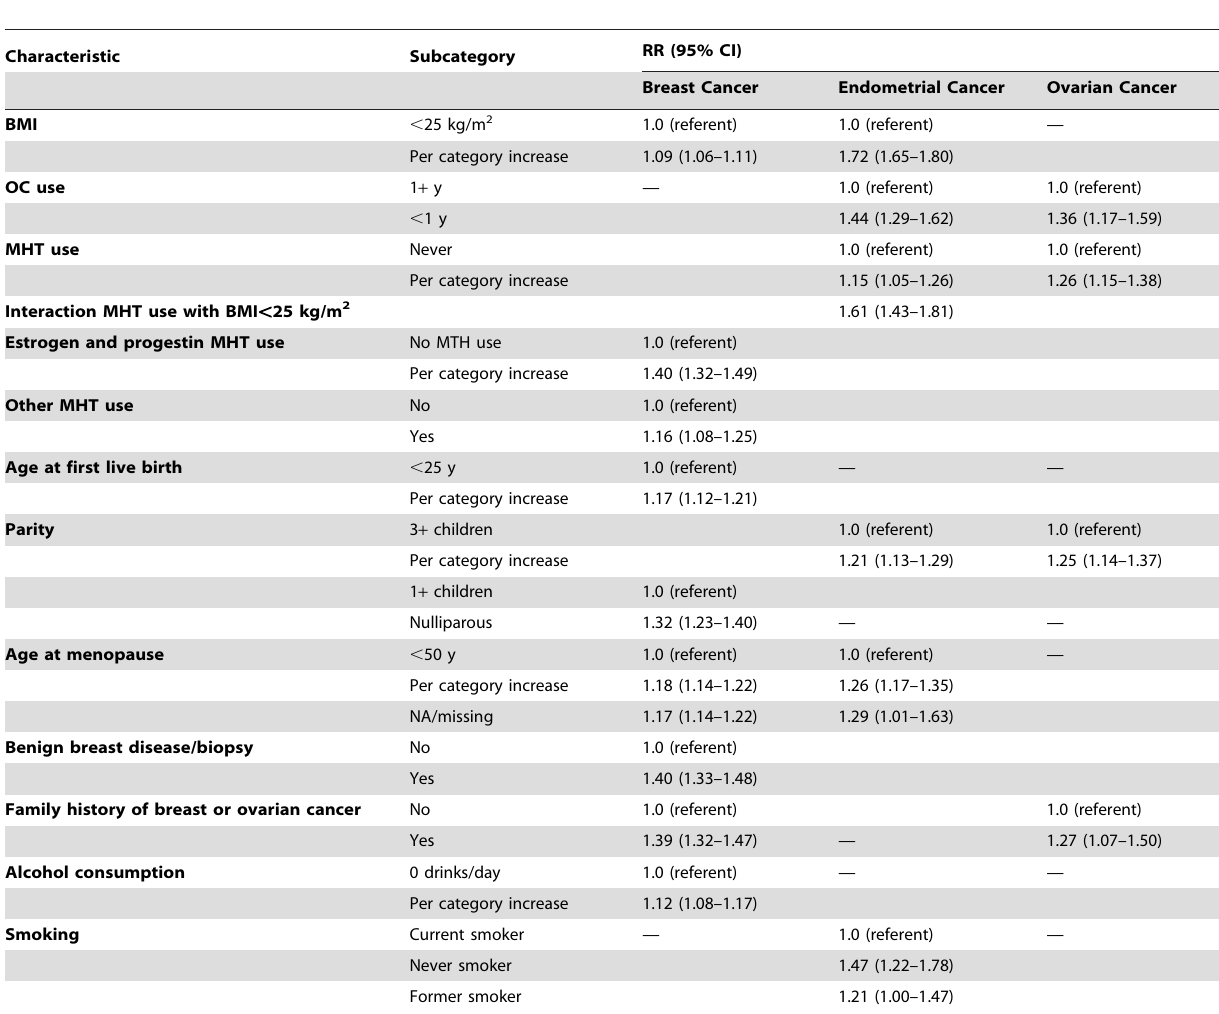
Table 6. Multivariate relative risk estimates for breast, endometrial, and ovarian cancer among non-Hispanic, white women in the NIH-AARP and PLCO